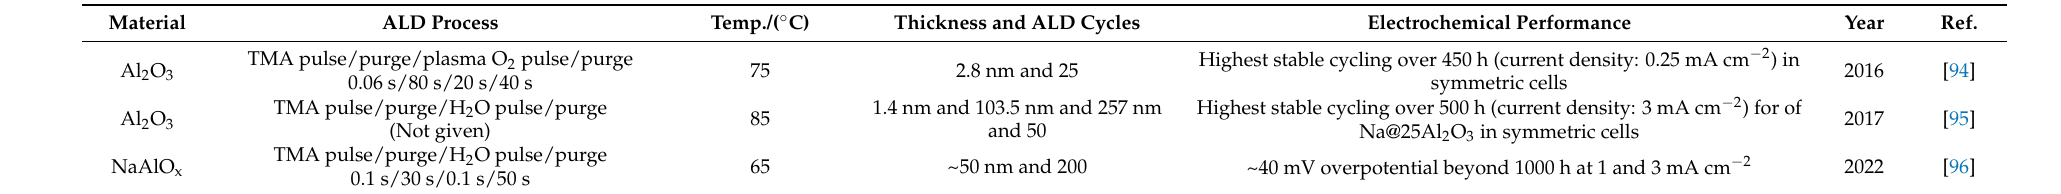
Table 2. Summary of ALD coating Na